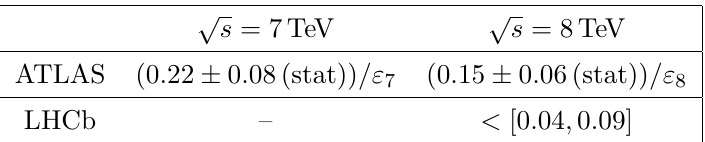
Table 3. Comparison of the R value between the LHCb upper limits at 95% CL and the ATLAS measurement [18], where 0 < " 7 ; 8 (cid:20) 1 are the relative e(cid:14)ciencies of reconstructing the B ( (cid:3) ) c (2 S ) + candidates with respect to the B + signals for the 7 and 8 TeV data, c